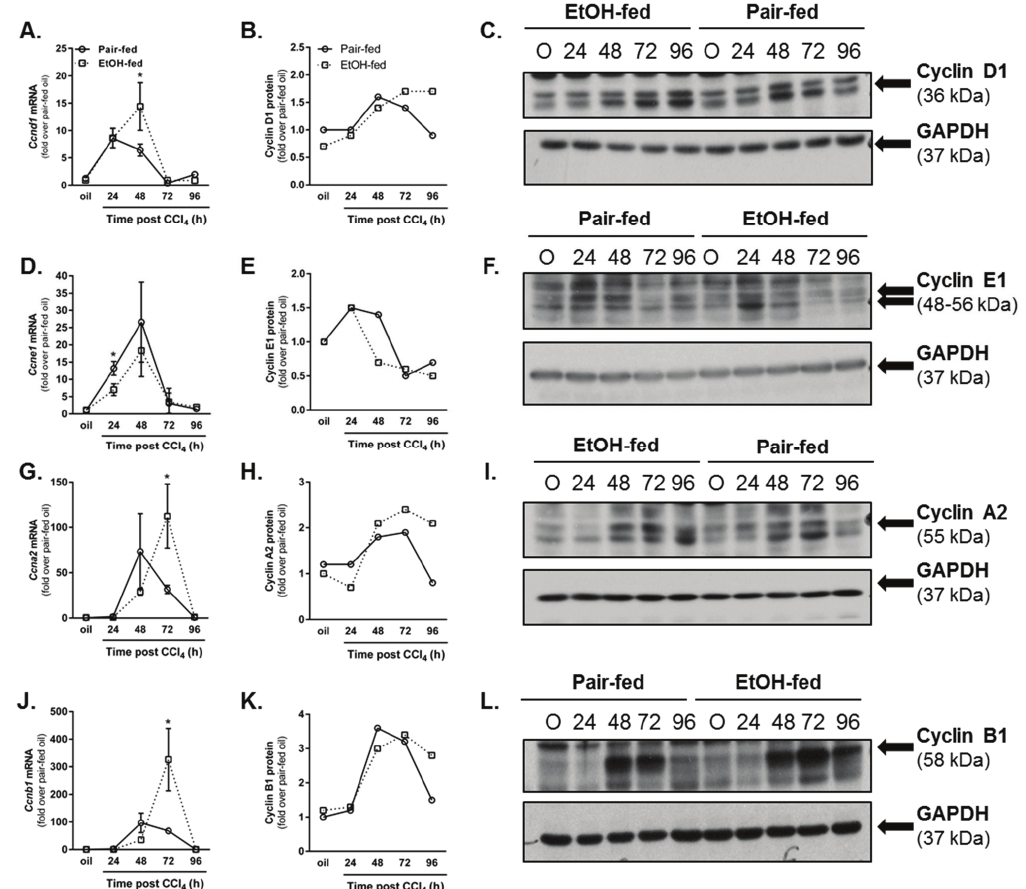
Figure 6. Moderate ethanol feeding enhanced hepatic cyclin content after CCl 4 exposure. Cyclin D1 ( A – C ), cyclin E1 ( D – F ), cyclin A2 ( G – I ) and cyclin B1 ( J – L ) were each analyzed in livers from pair-and ethanol-fed mice after CCl 4 exposure. In ( A , D , G , J ), real time PCR was used to determine hepatic content of cyclin transcripts while in ( C , F , I , L ), immunoblotting was used to determine hepatic cyclin protein content from pooled liver samples (n = 4–8 mice per group). Real time PCR data are expressed as fold change over pair-fed, olive oil exposed mice after normalization to 18S. Protein band integrated density was determined for each cyclin and GAPDH (loading control) band. After normalization to GAPDH, band densities were used to calculate fold change in cyclin protein over pair-fed mice exposed to olive oil (oil). N = 4–8 mice per group. * p < 0.05.